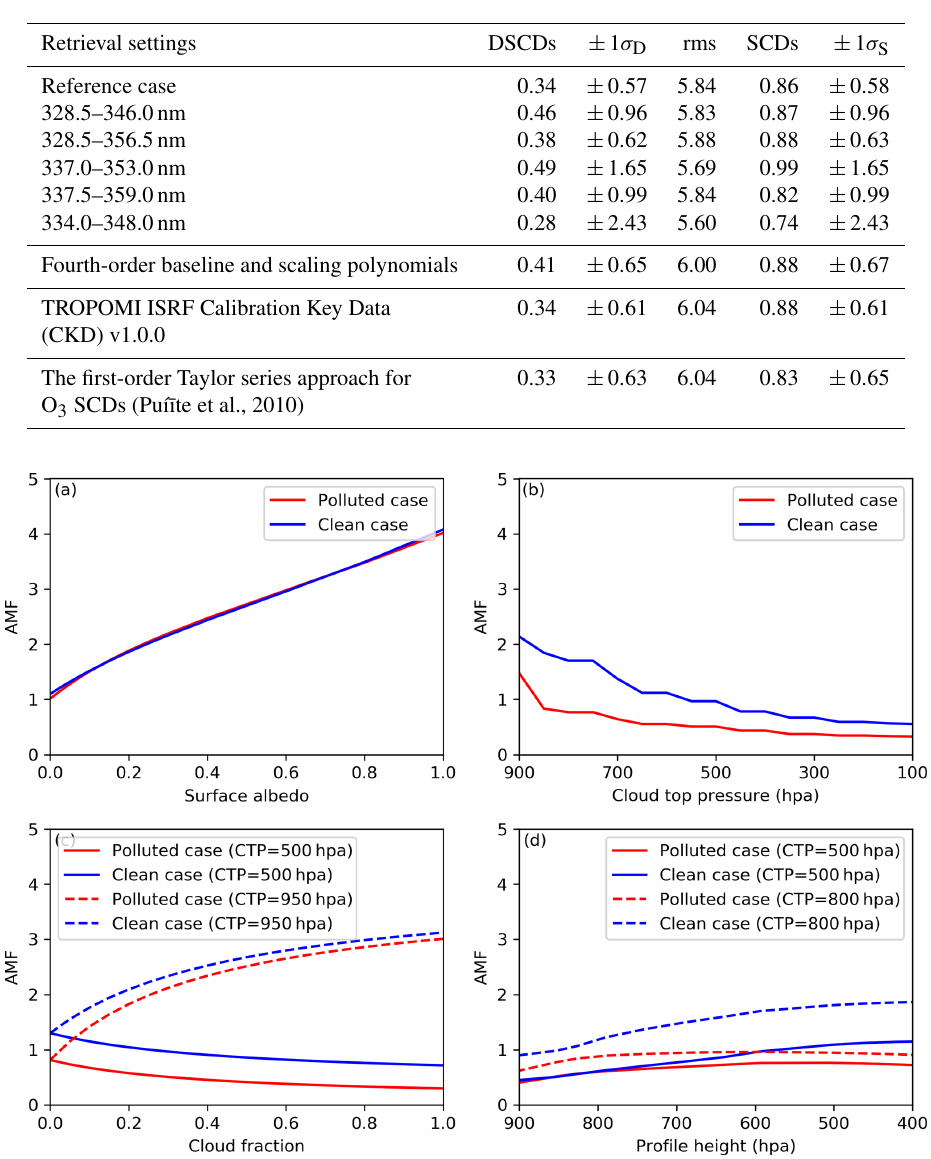
Figure 3. AMF variations with surface albedo (a), cloud top pressure (b) , cloud fraction (c) and profile height (d) over clean and polluted cases. In panel (a) , cloud fraction is 0. In panels (b) and (d) , cloud fractions are 0.3, and surface albedos are